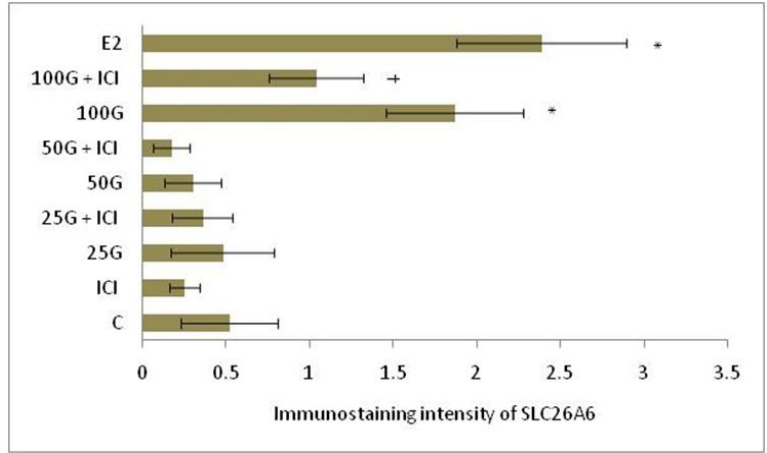
Figure 5. Quantitative evaluation of immunostaining intensity of SLC26A6 in the luminal epithelia following treatment with 25, 50 and 100 mg/kg/day genistein and estrogen by NIS-AR Element program. The intensity was the highest following treatment with estrogen, followed by 100 mg/kg/day genistein. C: control; ICI: ICI 182780; 25G: 25 mg/kg/day genistein; 50G: 50 mg/kg/day genistein; 100G: 100 mg/kg/day genistein; E2: estrogen. * p < 0.05 as compared to control; † p < 0.05 as compared to without ICI.